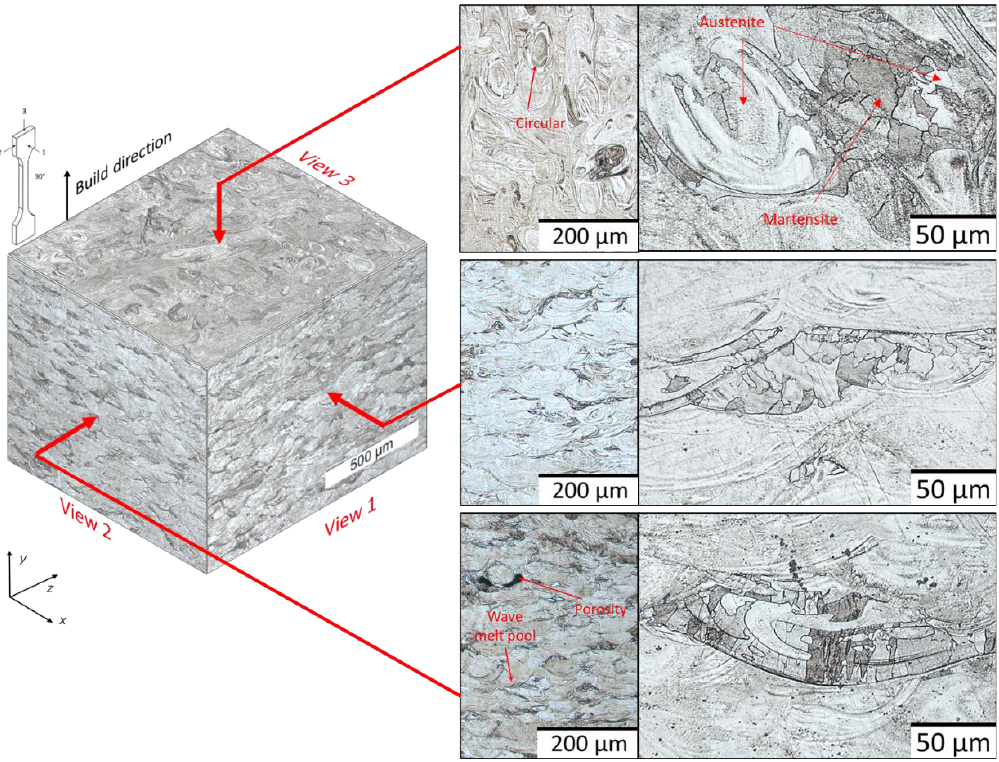
Figure 8. Microstructure profile for 90° build direction.